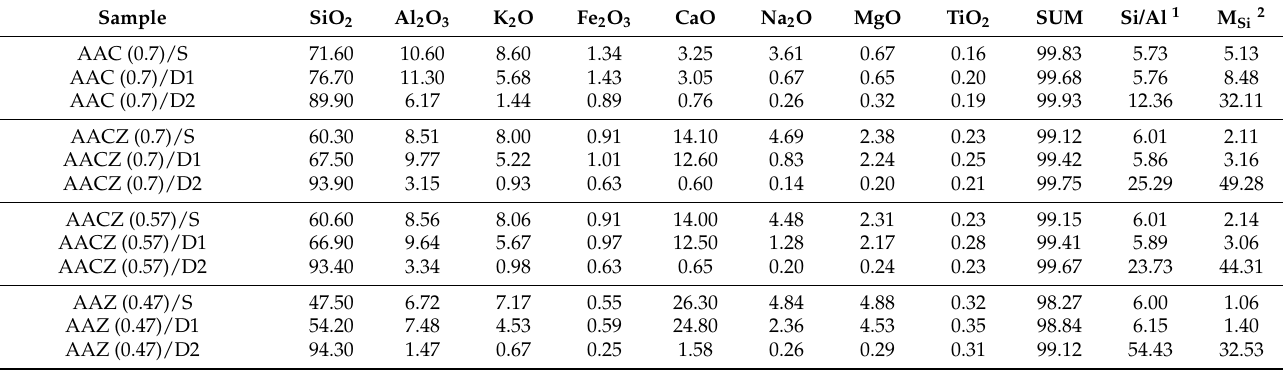
Table A1. Elemental composition determined by XRF